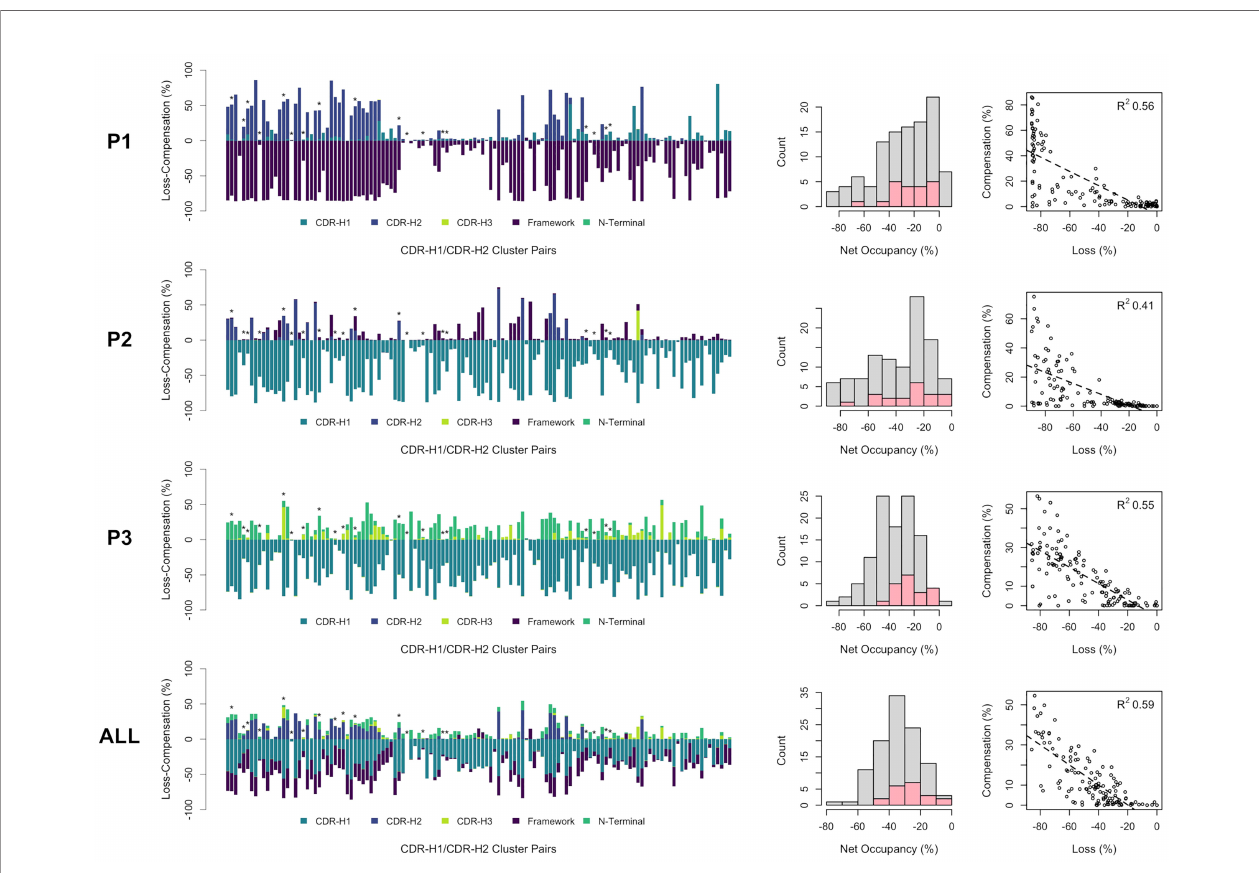
FIGURE 6 | Occupancies for all observed CDR-H1 and CDR-H2 cluster pairs of single-domain antibodies (in no particular order). The loss (negative) and compensation (positive) in occupancies are plotted (bar plots on the left) for the various regions that can occupy the pockets P1, P2, P3 and all three pockets combined. A template structure that fully occupies the pockets is used as reference (PDB: 3k74[B]). Major clusters are labelled with asterisks. Net occupancies (loss + compensation) for all cluster pairs are counted (middle histograms), with the major cluster pairs shown in pink. The correlations between the loss and compensation in occupancies for all cluster pairs are shown (scatter plots on the right) with associated Pearson coef fi cients (R 2